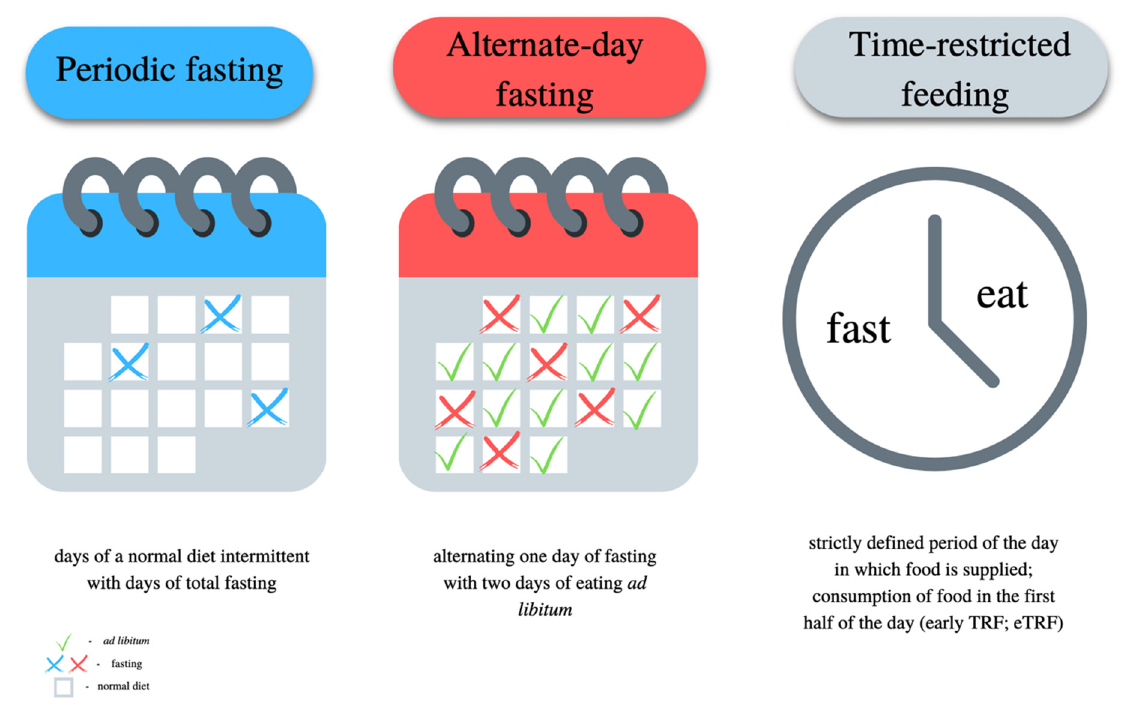
Figure 2. Characteristics of different types of fasting.